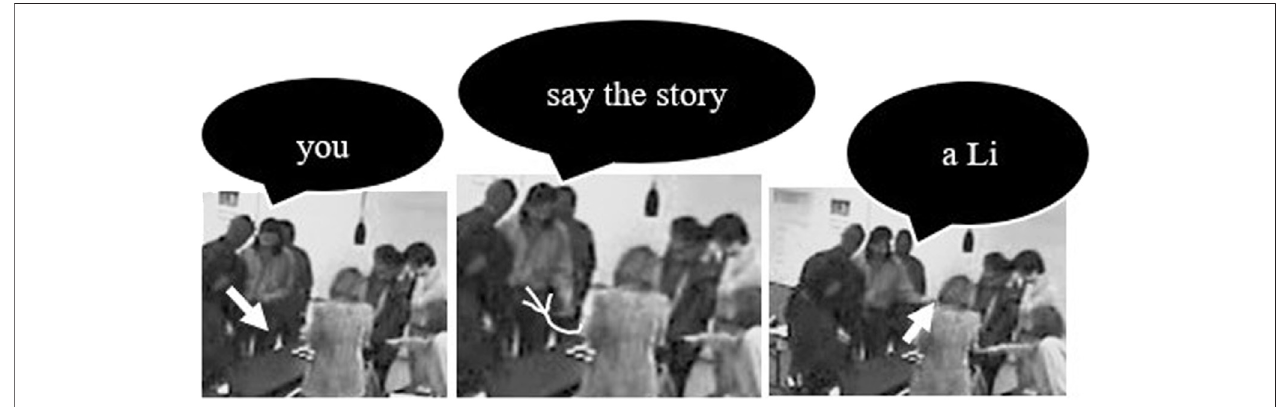
FIGURE 6 | Extract 3. line 4. (Arrows marking the trajectory of carlos ’ hand movement).